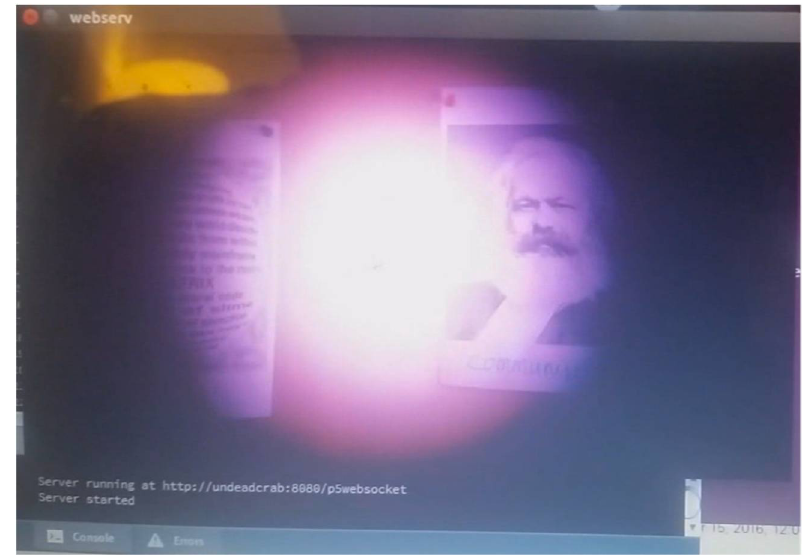
Figure 5. Student project, Communist Trappings .